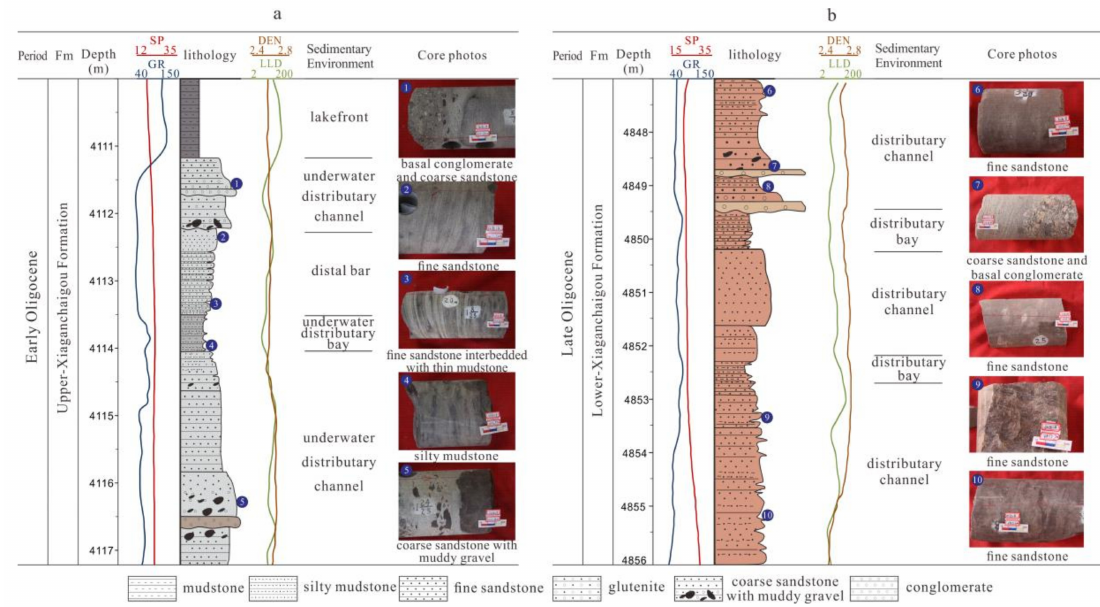
Figure 2. Sedimentological and petrophysical characteristics of the Xx1 well. ( a ): Upper-Xiaganchaigou Formation; ( b ): Lower-Xiaganchaigou